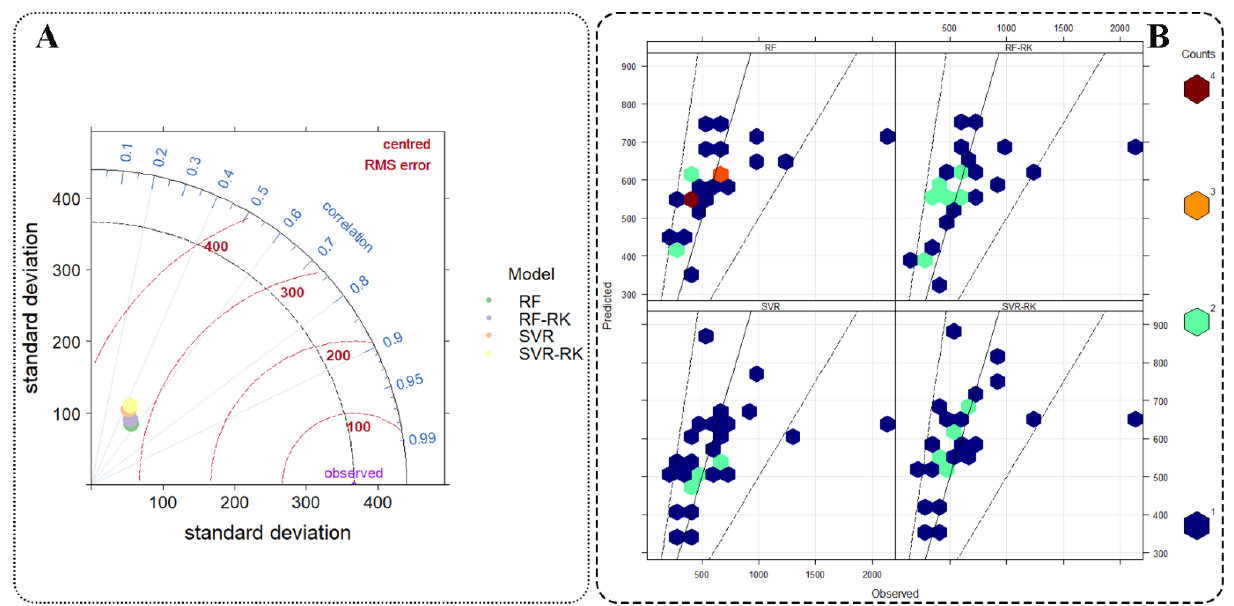
Figure 3. Taylor diagram for validation and hybrid model validation dataset ( A ). Predicted vs. observed soil EC in validation and hybrid model validation datasets ( B ). Abbreviations: SVR: support vector regression, RF: random forest, RK: regression-kriging.